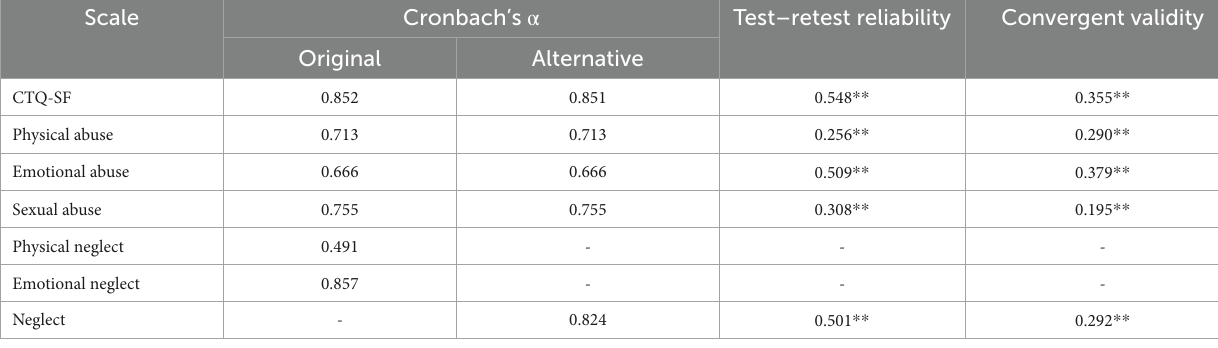
TABLE 3 Reliability and validity of the alternative CTQ-SF.